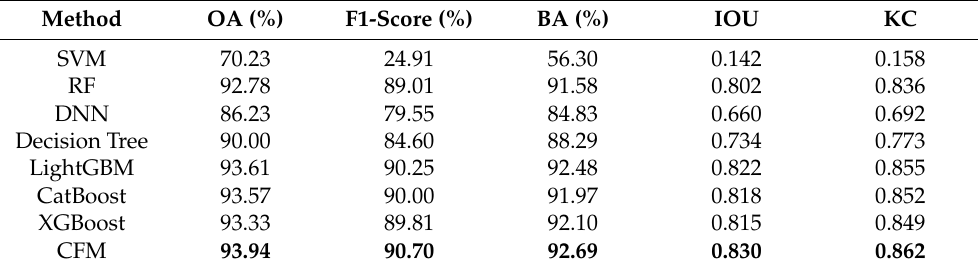
Table 8. Evaluation of the performance of different FSM models over the Karun basin using original dataset (before dimension reduction). OA: overall accuracy; IOU: intersection over union, BA: balance accuracy; KC: kappa coefficient. Support Vector Machine (SVM), Random Forest (RF), Deep Neural Network (DNN), Decision Tree (DT), Light Gradient Boosting Machine (LightGBM), Categorical Boosting (CatBoost), Extreme Gradient Boosting (XGBoost), and Cascade Forest Model (CFM). The highest value is in